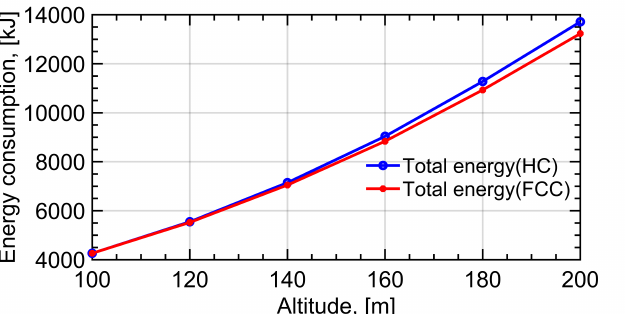
Figure 12. The variation in propulsion energy with the change in UAV’s altitude. The blue line represents the variation in UAV’s energy consumption when the altitude of UAV switchs from 100 m to 200 m under HC trajectory. The red line denotes the variation in UAV’s energy consumption under the proposed FCC